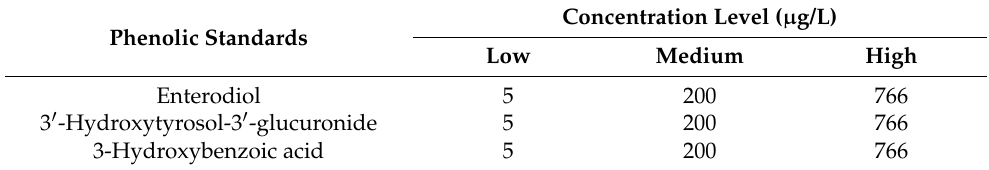
Table 1. Concentration levels of each phenolic standards for HPLC/ESI-LTQ-Orbitrap-HRMS method